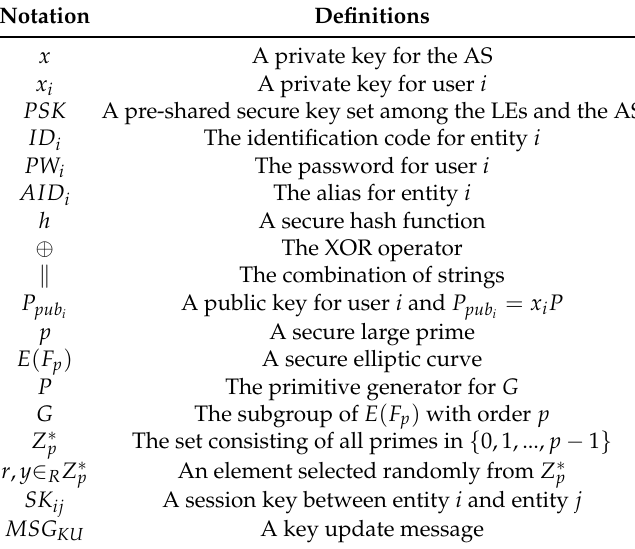
Table 1. The notations.